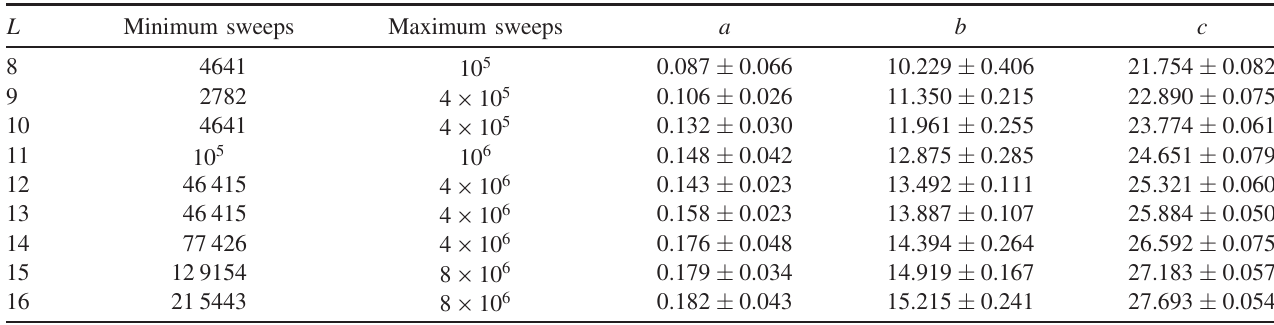
TABLE XVI. Fit to y ¼ a ð x − b Þ 2 þ c for the median results of the hardware-planted instances using the SVMC algorithm with y ¼ log TTS and x ¼ log n . The factor c does not include f sweeps SVMC